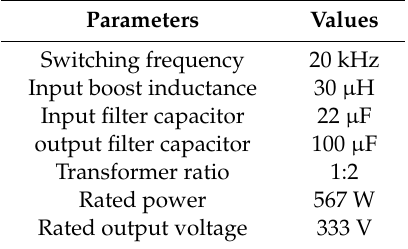
Table 1. Main parameters of the sub-modules.